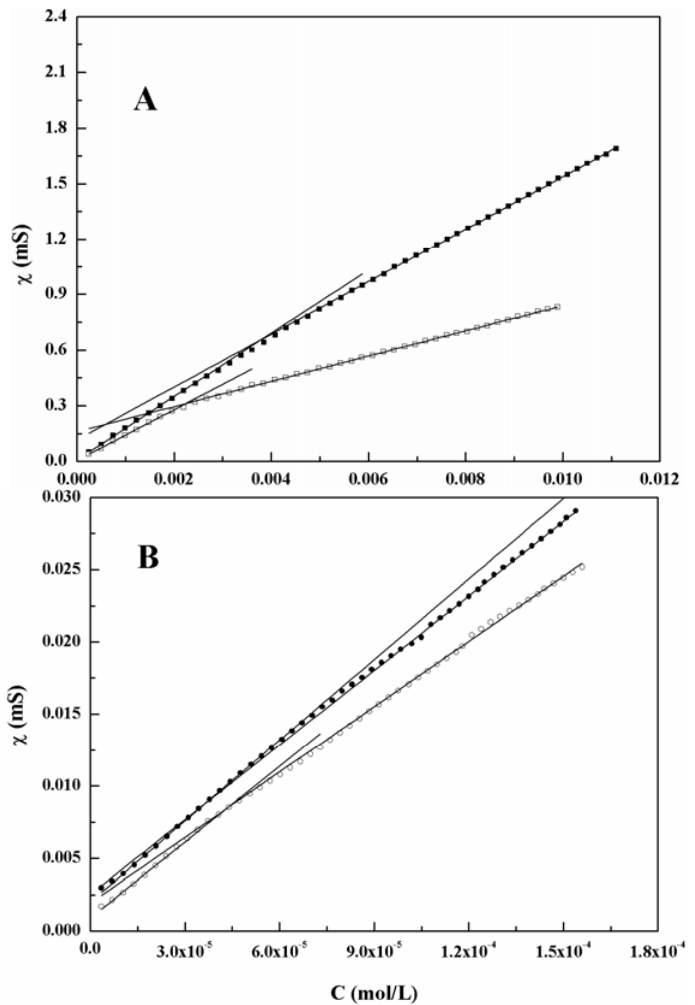
Figure 4. Conductivity values ( χ ) vs. molar concentration (C) for the gemini surfactants: ( A ) 4a (solid symbol) and 4b (open symbol); ( B ) 4c (solid symbol) and 4d (open symbol). The trend related to the compound 4c solution has been shifted by 0.001 mS for